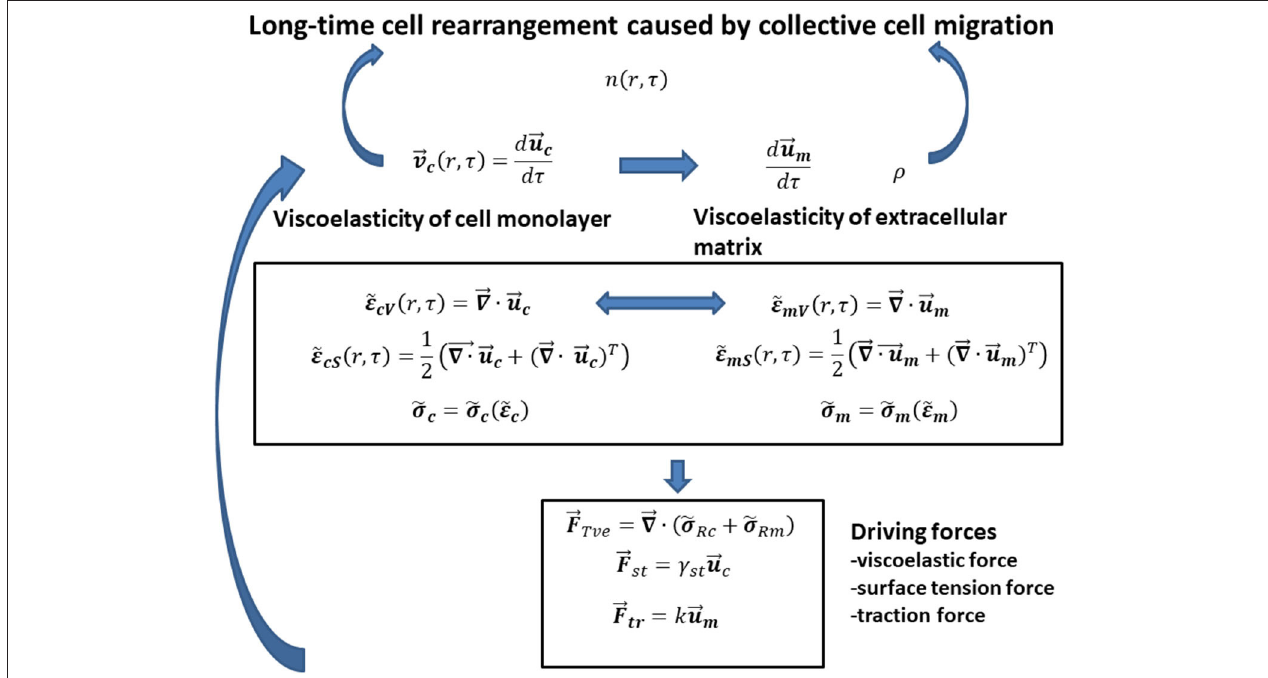
FIGURE 1 | The schematic representation of interrelations between main model parameters that influence the generation of mechanical waves during (1) monolayer free expansion and (2) cell swirling motion within a confluent